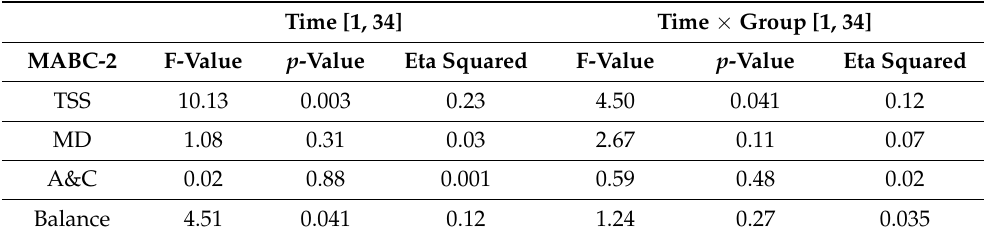
Table 2. Results of the repeated measures, the main effect of time (pre and post), and interaction effect of time by group (NTT and usual care) with F value, p -value, and effect size on MABC-2 standard scores (TSS = total standard score; MD = manual dexterity; A&C aiming and catching; and